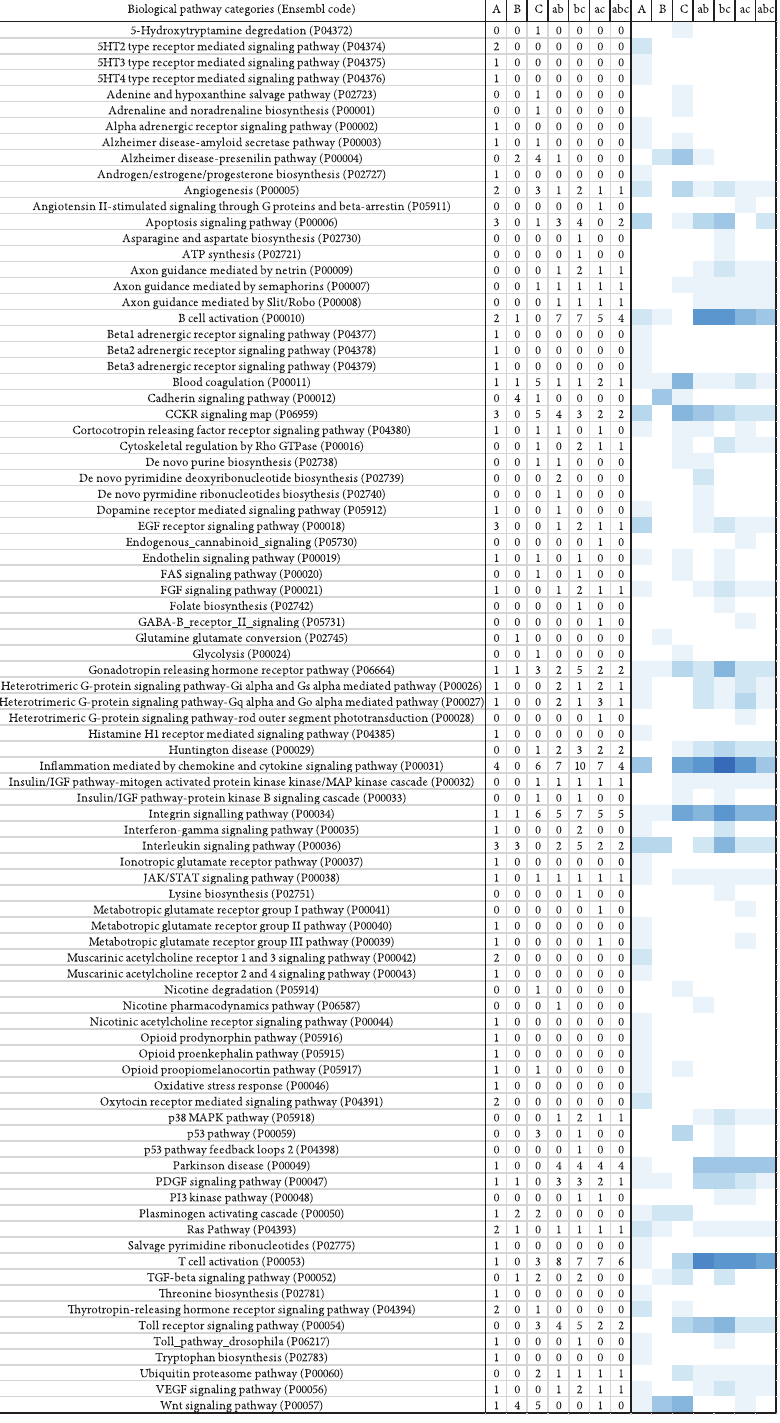
Figure 3: Heatmap from PANTHER biological pathway analysis. Heatmap was made with Plotly (available online at https://www.plot.ly/) with a white-to-blue color theme and drawn from RNA-Seq results from each group of 250 𝜇 A (A) only, 500 𝜇 A (B) only, and 2000 𝜇 A (C) only in addition to the intersections of 250 & 500 𝜇 A (ab), 250 & 2000 𝜇 A (ac), 500 & 2000 𝜇 A (bc), and all 3 current intensities